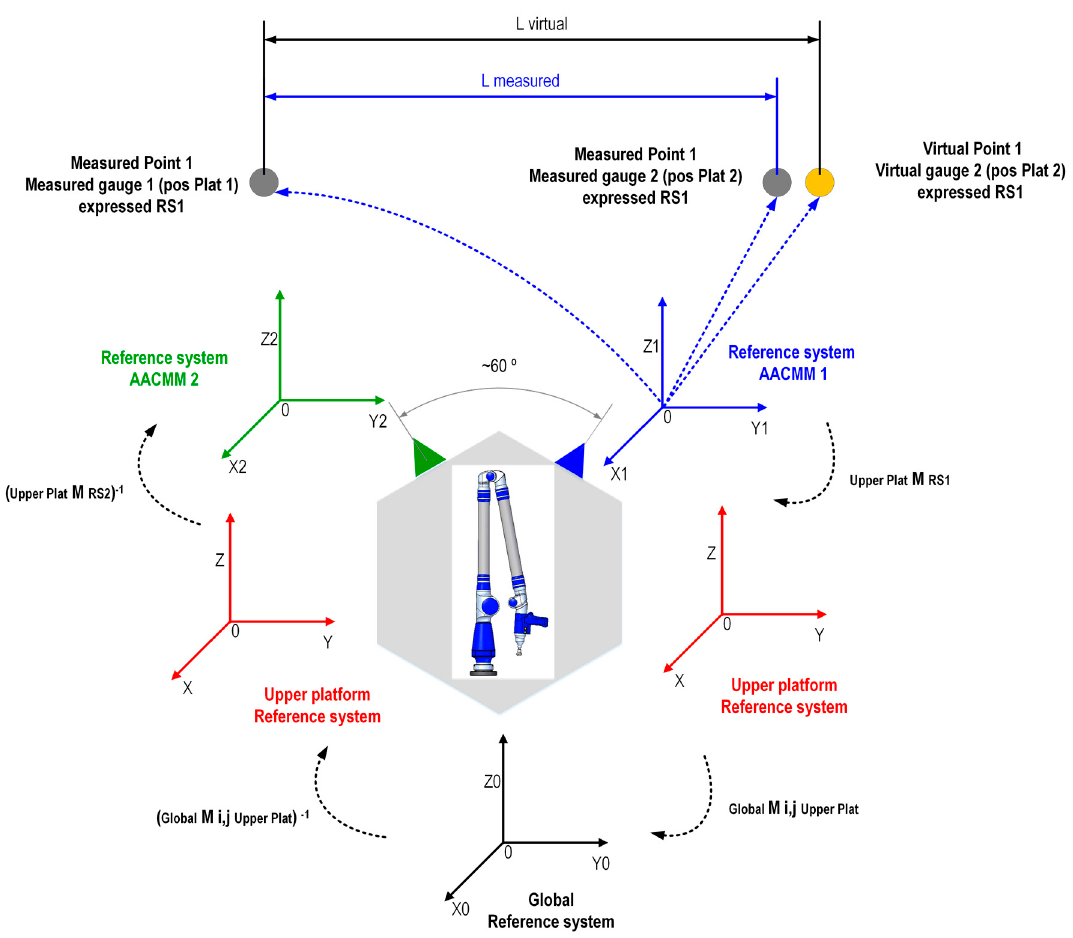
Figure 5. Measured distance and virtual distance concept.